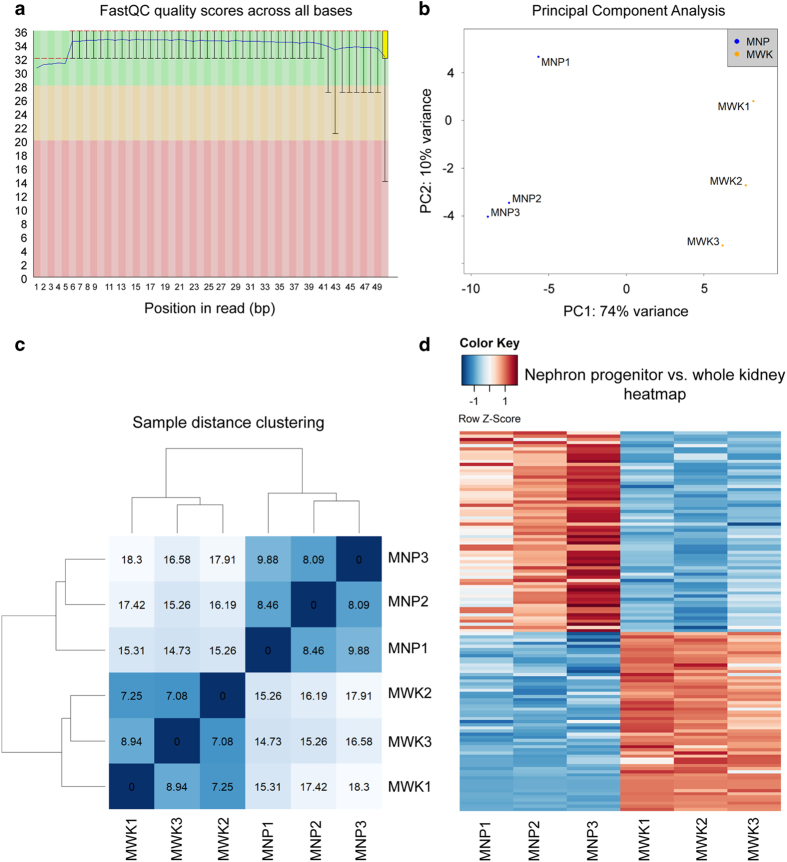
Quality control of the small RNA-Seq dataset showed good sequencing quality reads and congruence of the biological samples.(a) FastQC analysis of a sequenced library (MNP1) showing that each sequenced base had a mean value score of >30, indicating good quality sequencing. (b) Principal Component Analysis of the sRNA-Seq dataset showed clear separation of the nephron progenitor (MNP) and whole kidney (MWK) samples. (c) Hierarchical clustering correctly grouped samples based on their tissue of origin. (d) Heatmap representation of differentially expressed miRNAs in nephron progenitors vs. whole kidney samples with a false discovery rate of 0.05.